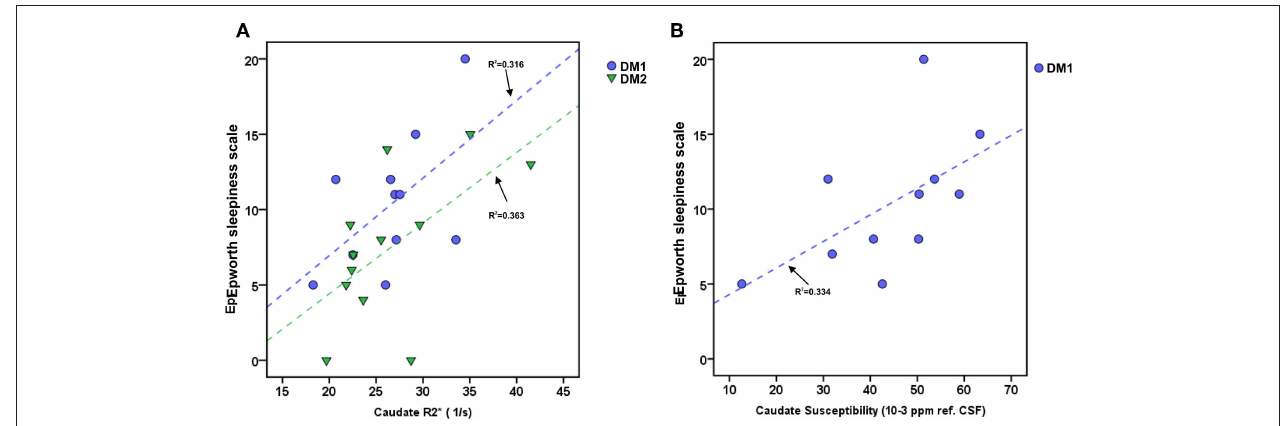
FIGURE 3 | Associations between daytime sleepiness (ESS) and Caudate R2* or Caudate susceptibility in DM1 and DM2. (A) Scatterplot of ESS and Caudate R2* in DM1 (blue) and DM2 (green). (B) Scatterplot of ESS and Caudate susceptibility (unit: ppm referenced to CSF) in DM. Dashed lines: linear regression (R 2 = regression